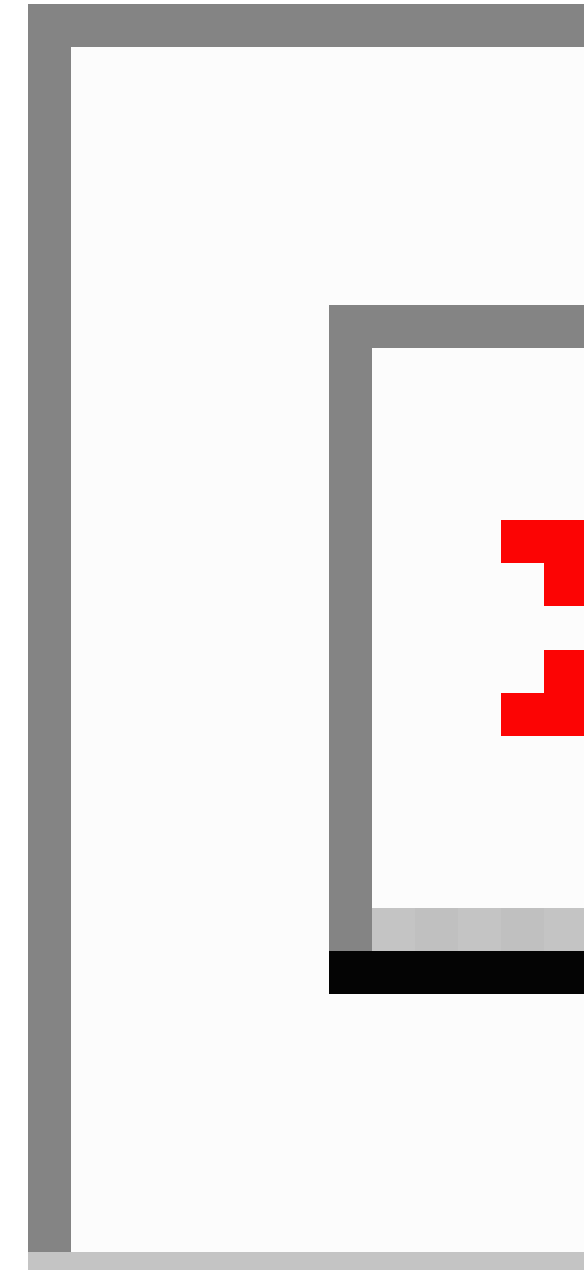
Figure 7. Screenshot of Community